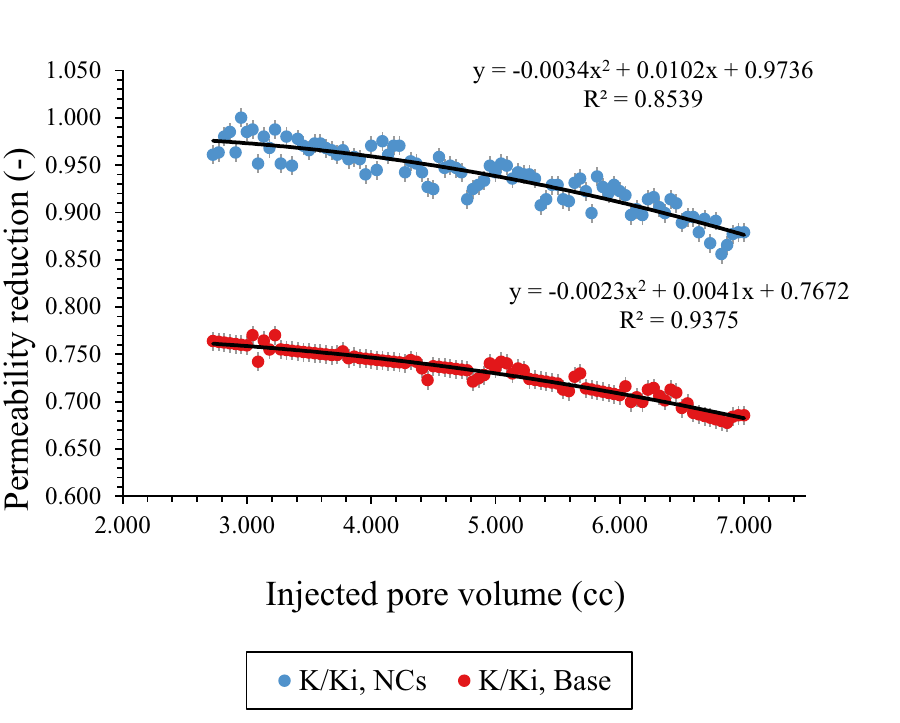
Figure 12. Permeability reduction in the presence of NCs during CO 2